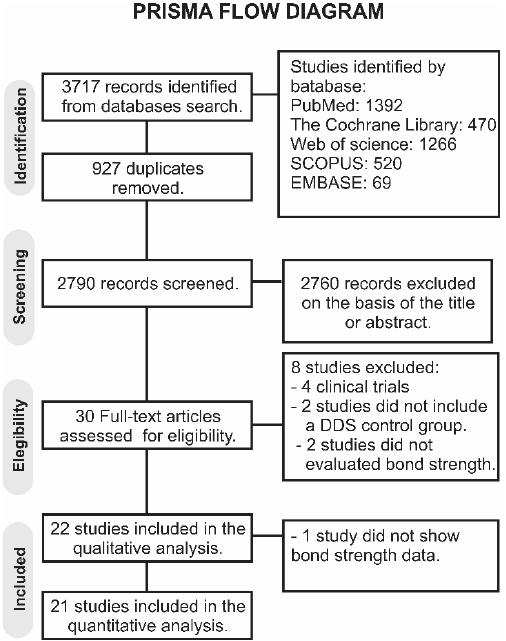
Figure 1. PRISMA flow diagram of the study.